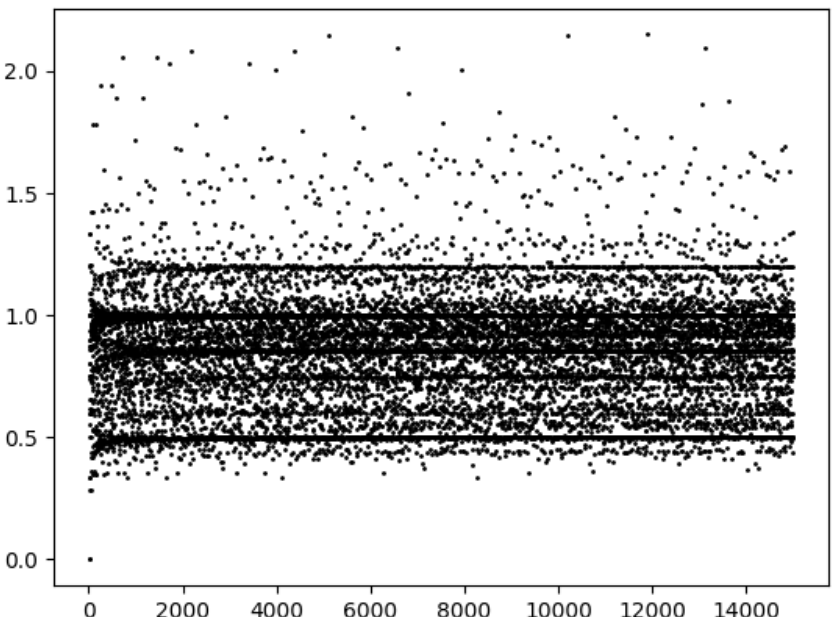
Figure 4. Plot of R (ordinate) for m (abscissa) up to 15,000. More often than not, the nonsquare excess is below one. There also appear to be striations of high concentrations of particular values of R